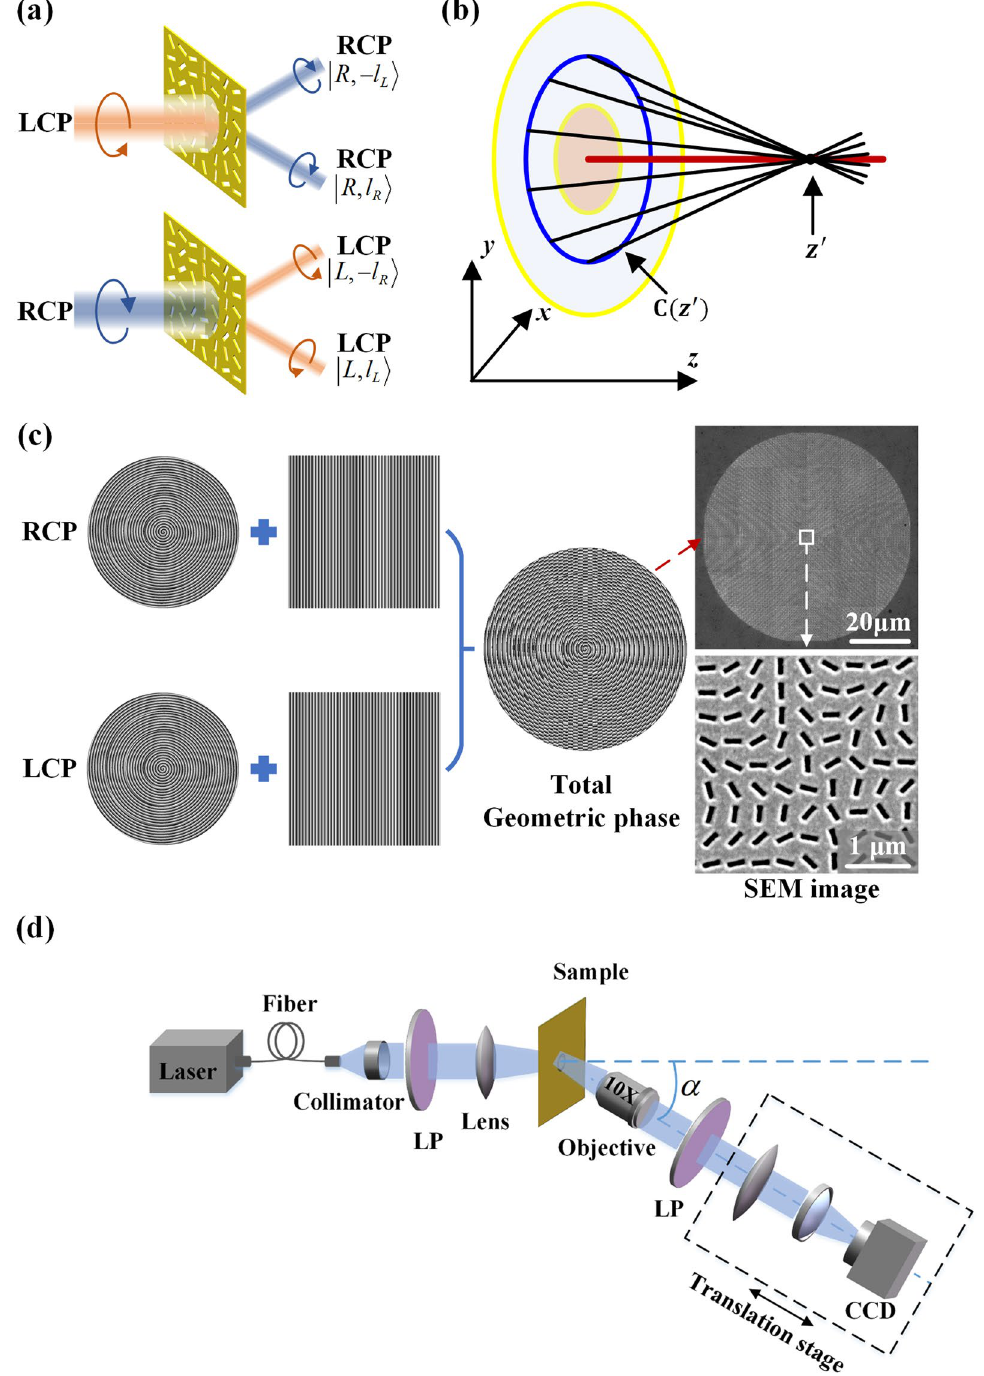
Figure 2. ( a ) The deflected RCP and LCP beams through the metasurface. ( b ) Schematic of the formation of caustic curve. ( c ) Generation steps of the total geometric phase profile for producing the space-variant vector vortex beam. The right column is the SEM images of the whole metasurface (upper figure) and the central part of metasurface marked by the white square (bottom figure). ( d ) Schematic illustration of the experimental setup to characterize the vector vortex